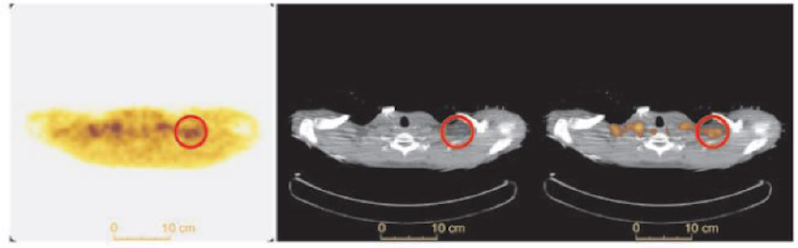
Figure 7. BAT FTHA uptake in a healthy human subject. Transverse FTHA-PET (left panel), CT (middle panel) and fused PET/CT (right panel) in a healthy subject after 1 hour of cold exposure. Supraclavicular BAT is shown in the red circle. Image reproduced with permission from reference